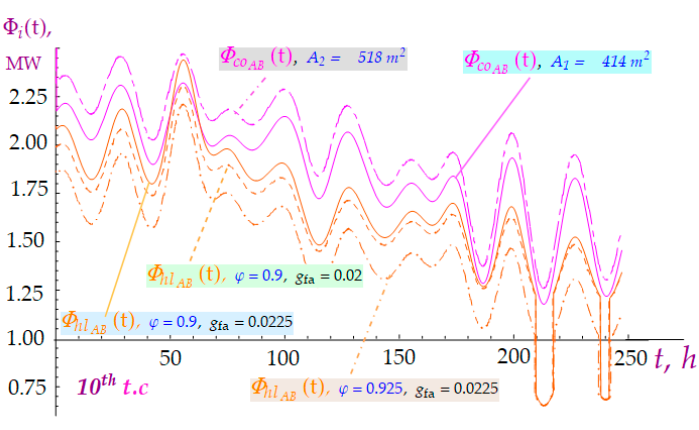
( t ) for different evaporator area and heating loads Φ Φ ( ) t for different evaporator area and heating loads Φ ( ) Φ ( ) AB t for different evaporator area and heating loads Φ ( ) AB co AB co g , during 10th transport cycle. and g , during 10th transport cycle. and fa a fa a